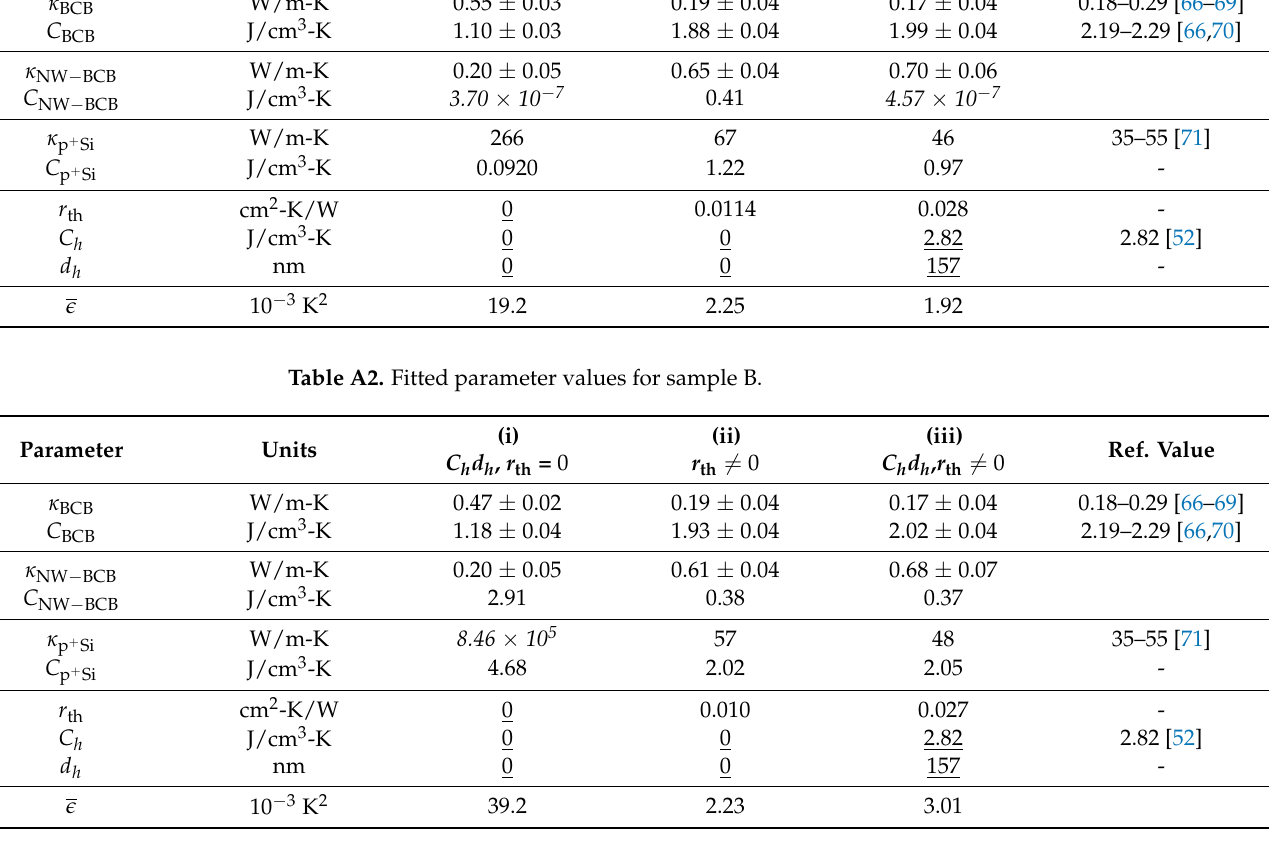
Table A3. Fitted parameter values for sample